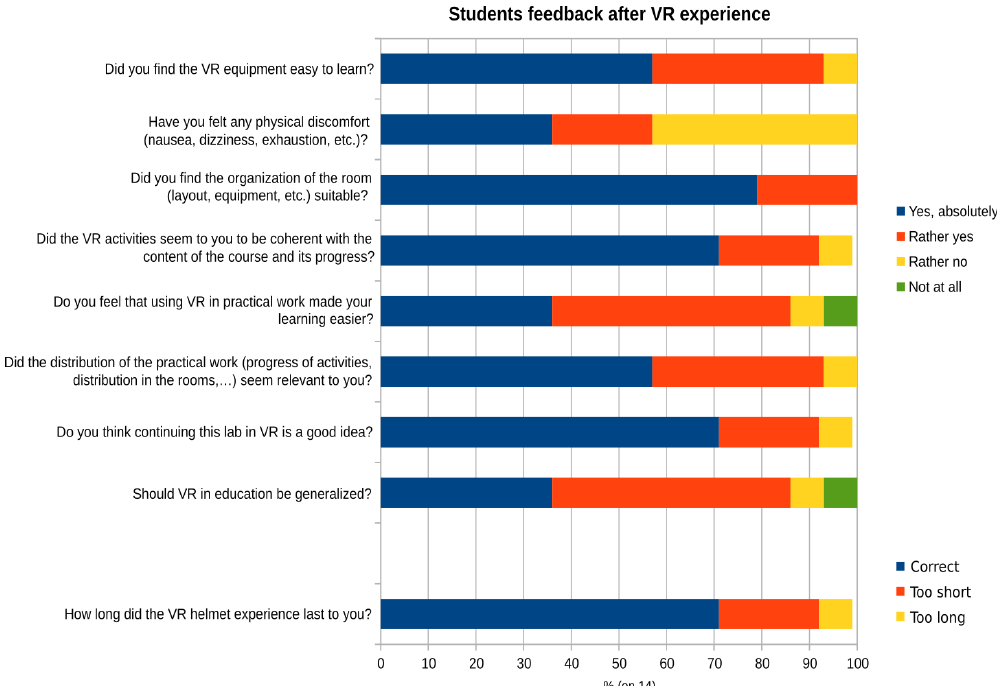
Figure 6. Results from the online inquiry given to the students who participated in the VR lab session. A total of 14 out of 20 students answered. Questions have been translated from French by the